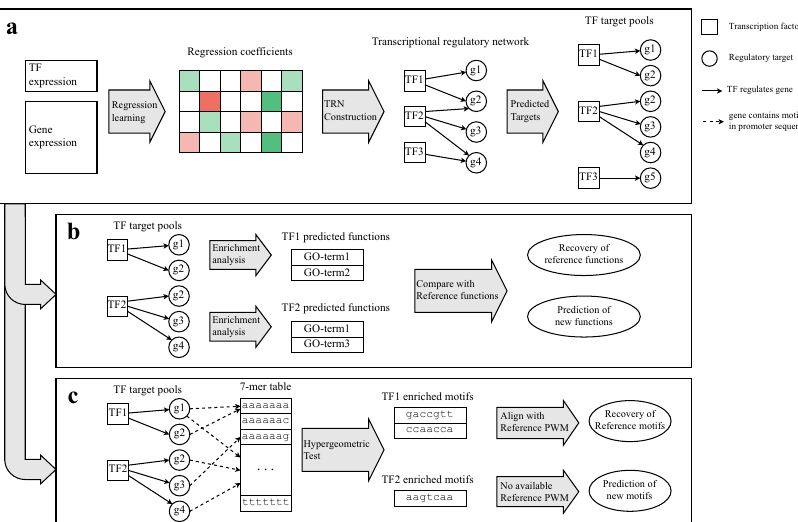
Figure 1. Overview of the methodology. ( a ) Gene expression data is fitted by regression models to produce the regression coefficients, which are then transformed into a transcriptional regulatory network. The predicted target genes for each transcription factor can be extracted from this network. ( b ) GO enrichment analysis on target pools yields statistically significant candidate functions for TFs. Candidate functions are cross-checked with the reference database. ( c ) Promoter sequences for genes associated with every 7-mer that is present in them. Hypergeometric test is used to identify statistically significant 7-mers enriched in the target pools of TFs. The significantly enriched 7-mers are compared with reference